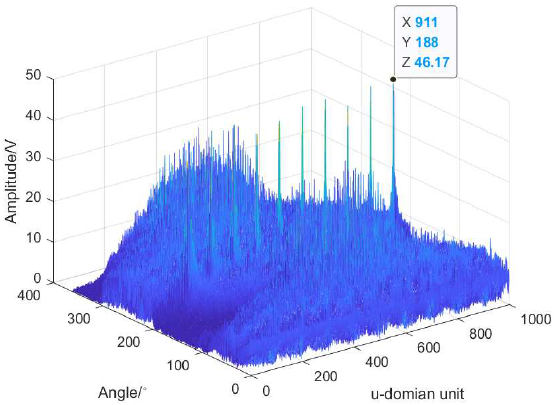
Figure 9. FRFT of the mixed